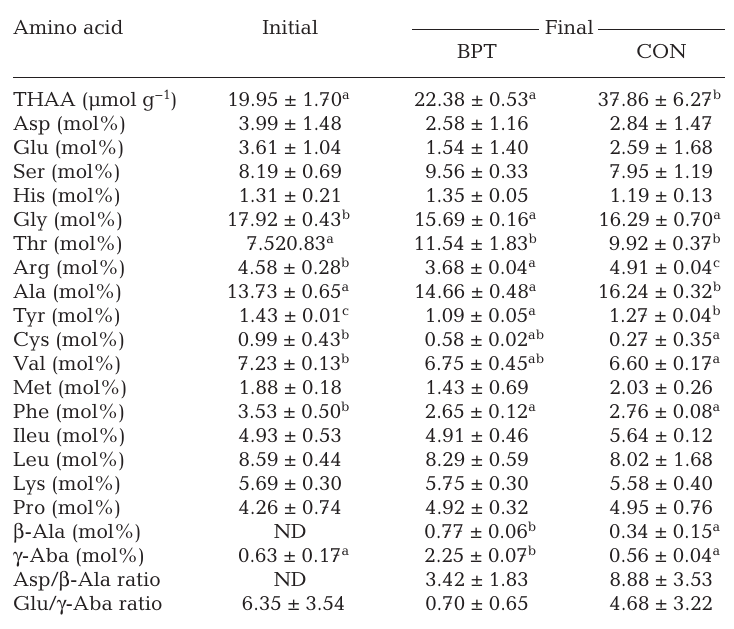
Table 2. Total hydrolysable amino acid (THAA) composition of the surface sediment. Data are presented as mean ± SD (n = 3). Different letters within the same row indicate significant differences (p < 0.05) between the final Bellamya purificata treatment (BPT), the final control (CON), and the corresponding initial values. See Table 1 for